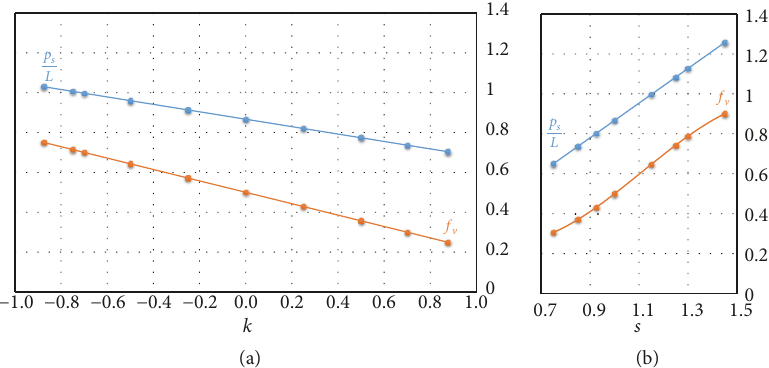
Figure 4: Trend of volume fraction 𝑓 V and of pore size 𝑝 𝑠 /𝐿 with (a) 𝑠 = 1 and 𝑘 ∈] − 1 1[ and (b) 𝑘 = 0 and 𝑠 ∈ [0.75 1.5[ .